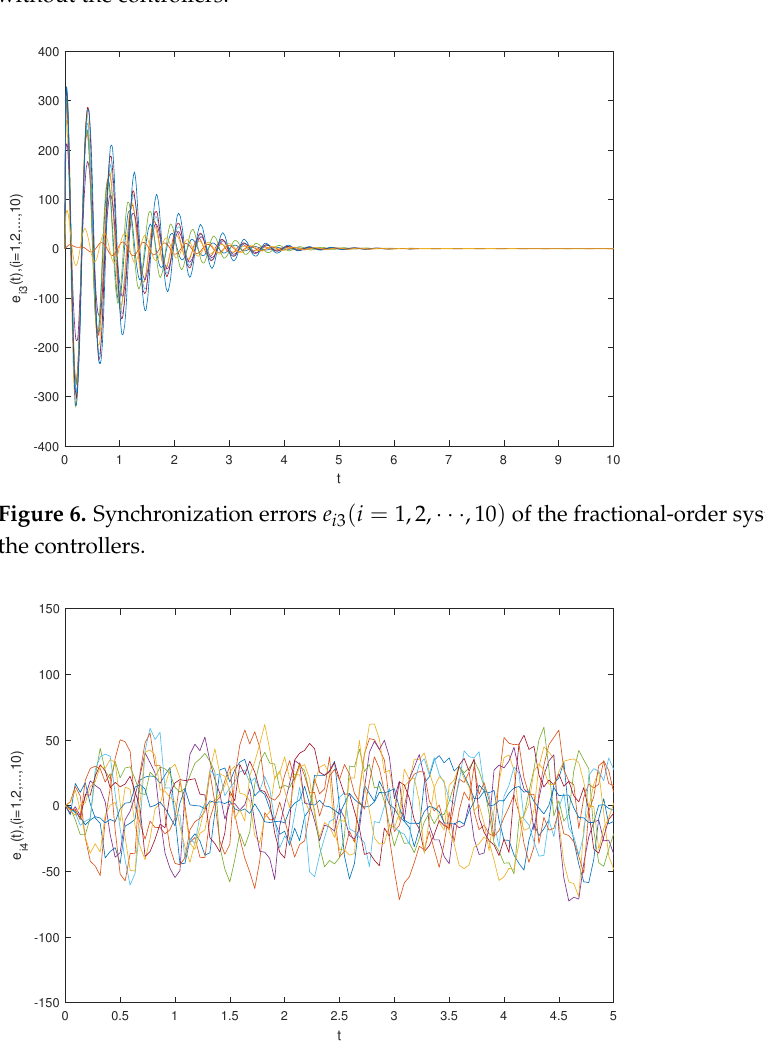
Figure 5. Synchronization errors e i 3 ( i = 1,2, · · · ,10 ) of the fractional-order system (32) and (33) without the controllers.